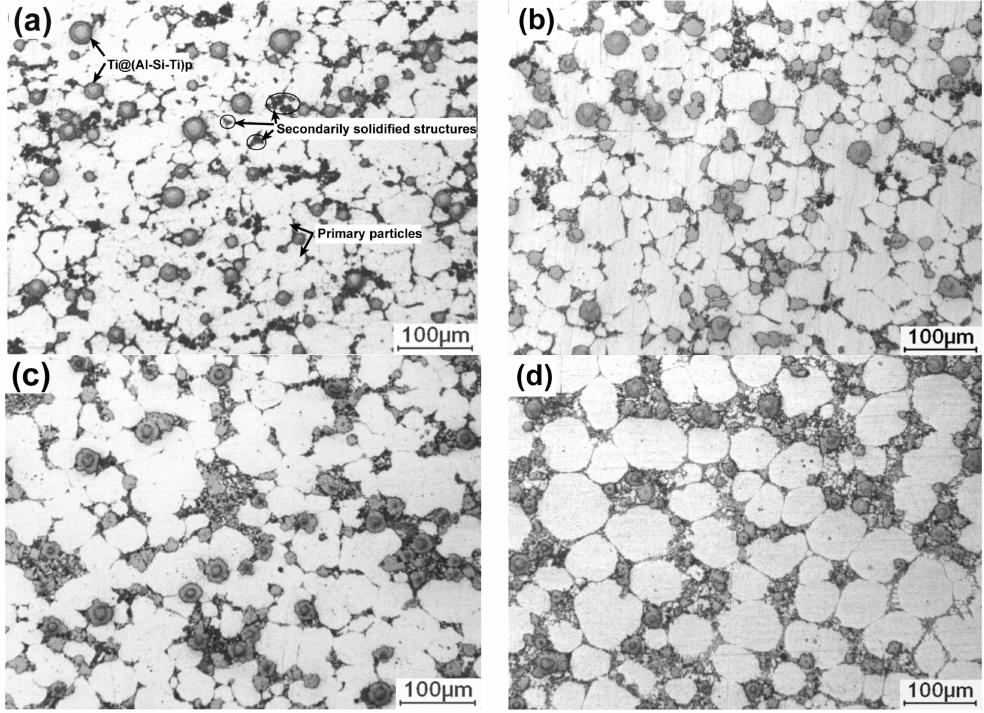
Figure 1. OM images of the composites thixoformed at reheating temperatures of ( a ) 590 ◦ C, ( b ) 600 ◦ C, ( c ) 605 ◦ C, and ( d ) 610 ◦